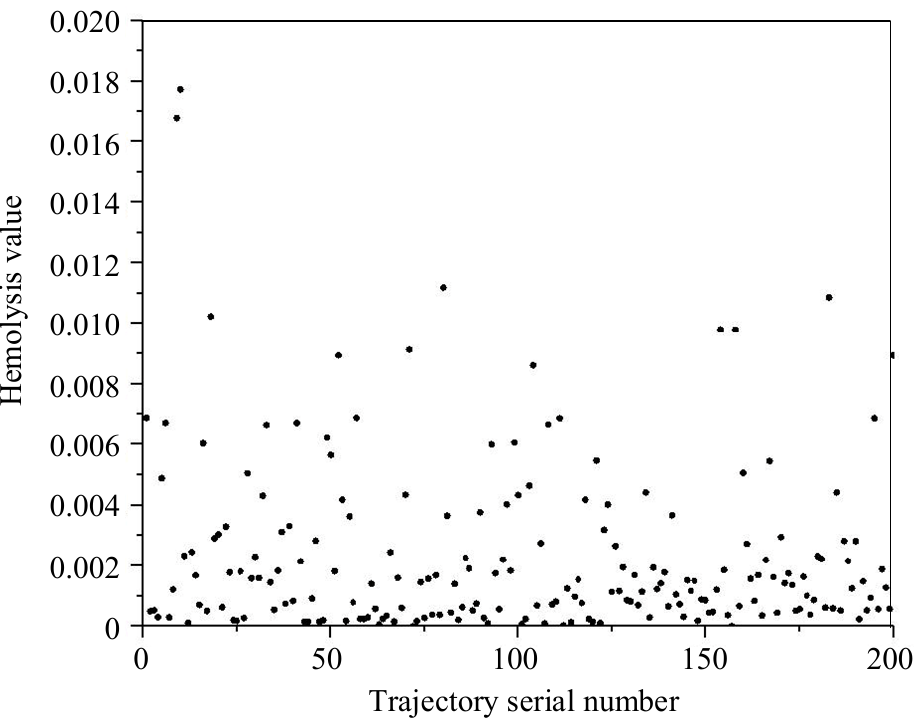
Figure 13. Hemolysis prediction values of blood